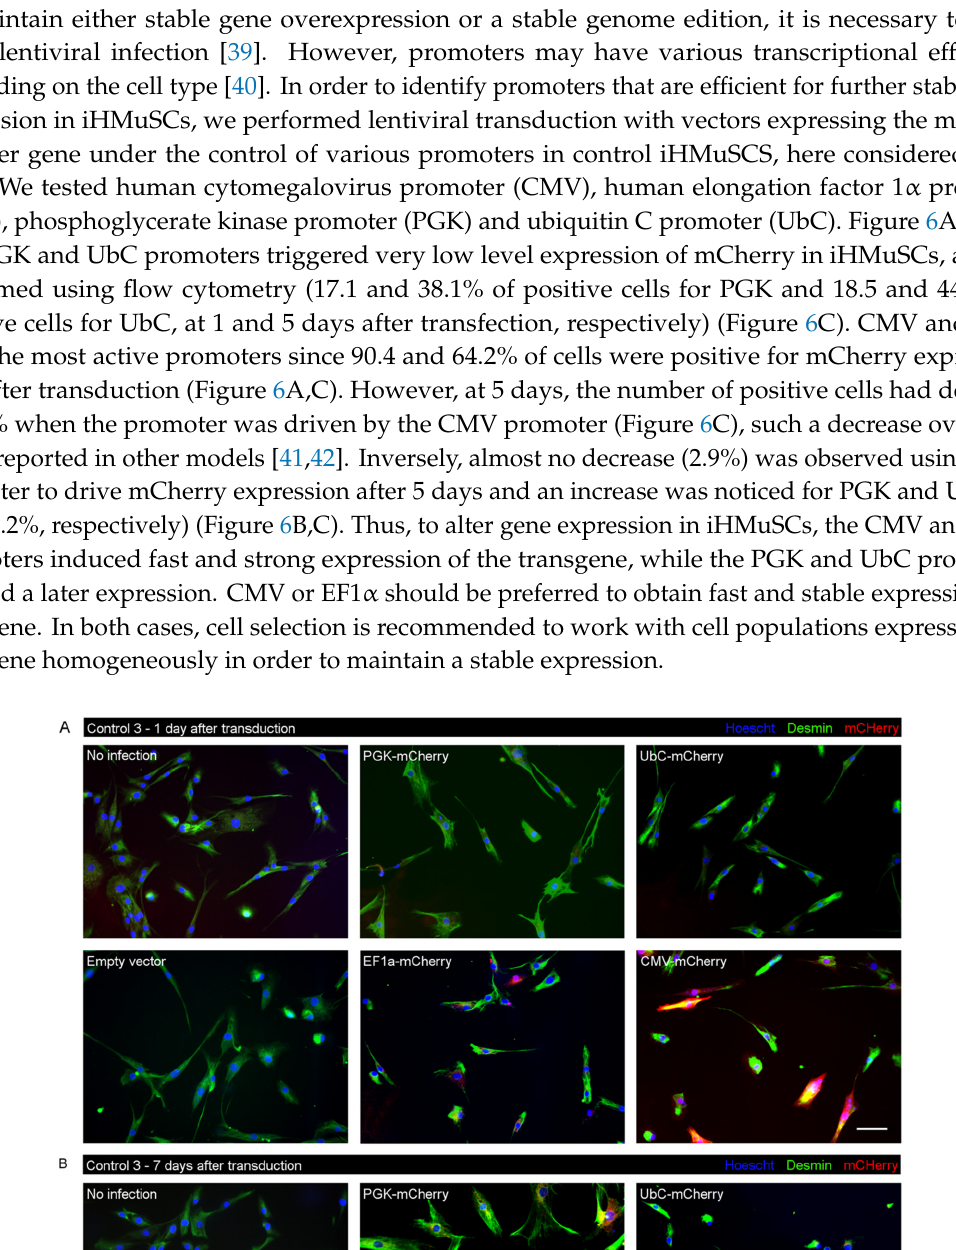
Figure 6. Lentiviral transduction of mCherry reporter gene under the control of several promoters. iHMuSCs control 1—D52, control 2—E4 and control 3—A42 were transduced with lentiviruses containing mCherry under the control of PGK, UbC, EF1 or CMV promoters or with an empty